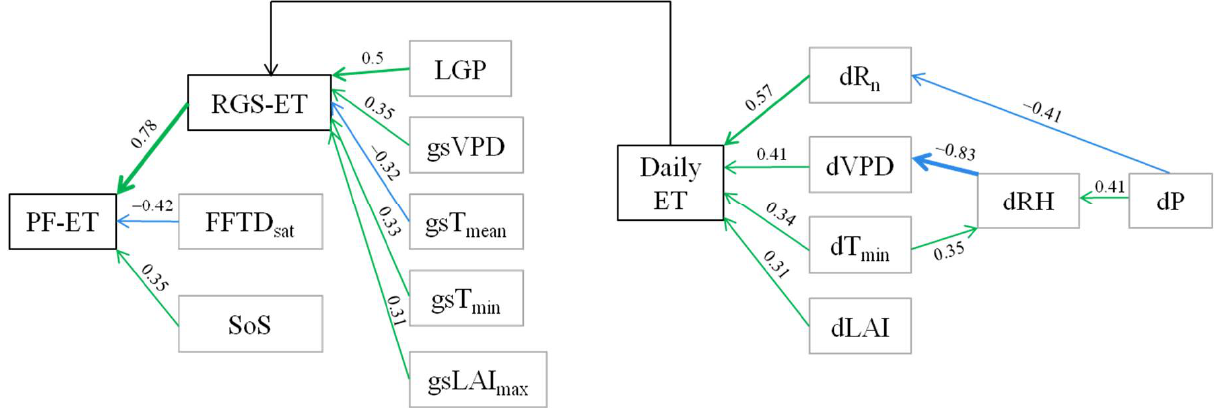
Figure 3. Apath diagram presenting significant relationships and the causal direction for the paddy field total ET ( PF-ET , the sum of daily ET from the FFTD sat to the EGS , mm m − 2 ), and the rice-growing season total ET ( RGS-ET , the sum of daily ET from the SoS to the EGS , mm m − 2 ), with various biophysical factors, including the growing season onset of rapid canopy expansion ( SoS , DOY), the first date of field flooding and transplanting identified by satellite observations ( FFTD sat , DOY), the length of the growing period ( LGP , days), the mean vapor pressure deficit ( gsVPD , kPa) during the growing season, the daily mean air temperature ( gsT mean , ◦ C) during the growing season, the mean minimum air temperature ( gsT min , ◦ C) during the growing season, the maximum leaf area index ( gsLAI max , m 2 m − 2 ) during the growing season, the daily net radiation over the rice-growing season ( dR n , MJ m − 2 day − 1 ), the daily VPD ( dVPD , kPa), the daily T min ( dT min , ◦ C), the daily LAI ( dLAI , m 2 m − 2 ), the daily relative humidity ( dRH , %) and the daily precipitation ( dP , mm). Numerical value attached to the arrow symbol was path coefficient. Green (blue) sign indicated a positive (negative) correlation. DOY: day of